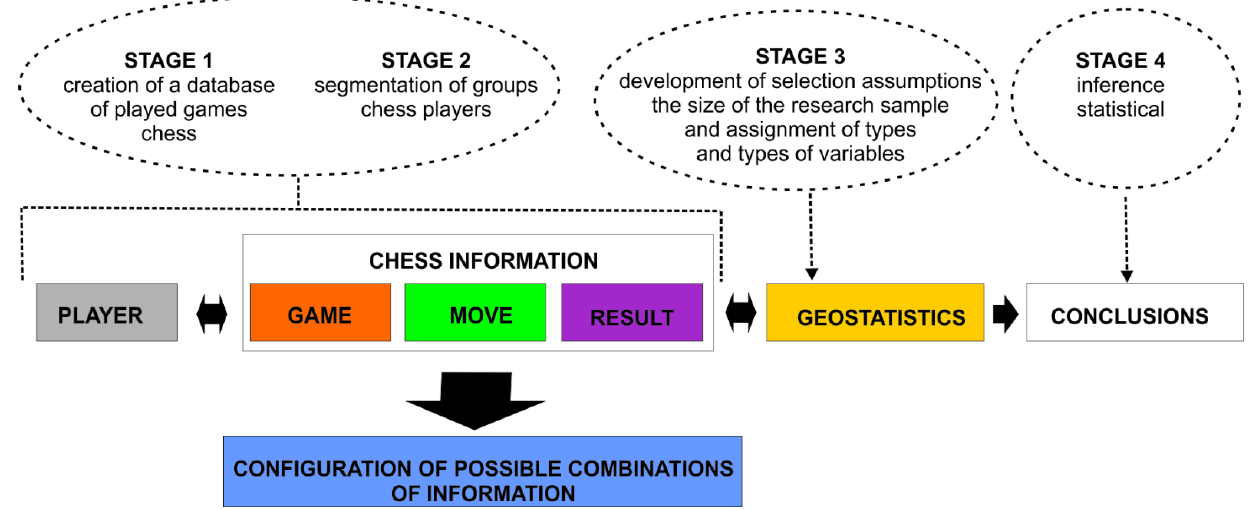
Figure 2. The model of social geospatial analysis using data obtained from the games of chess. Source: own study.